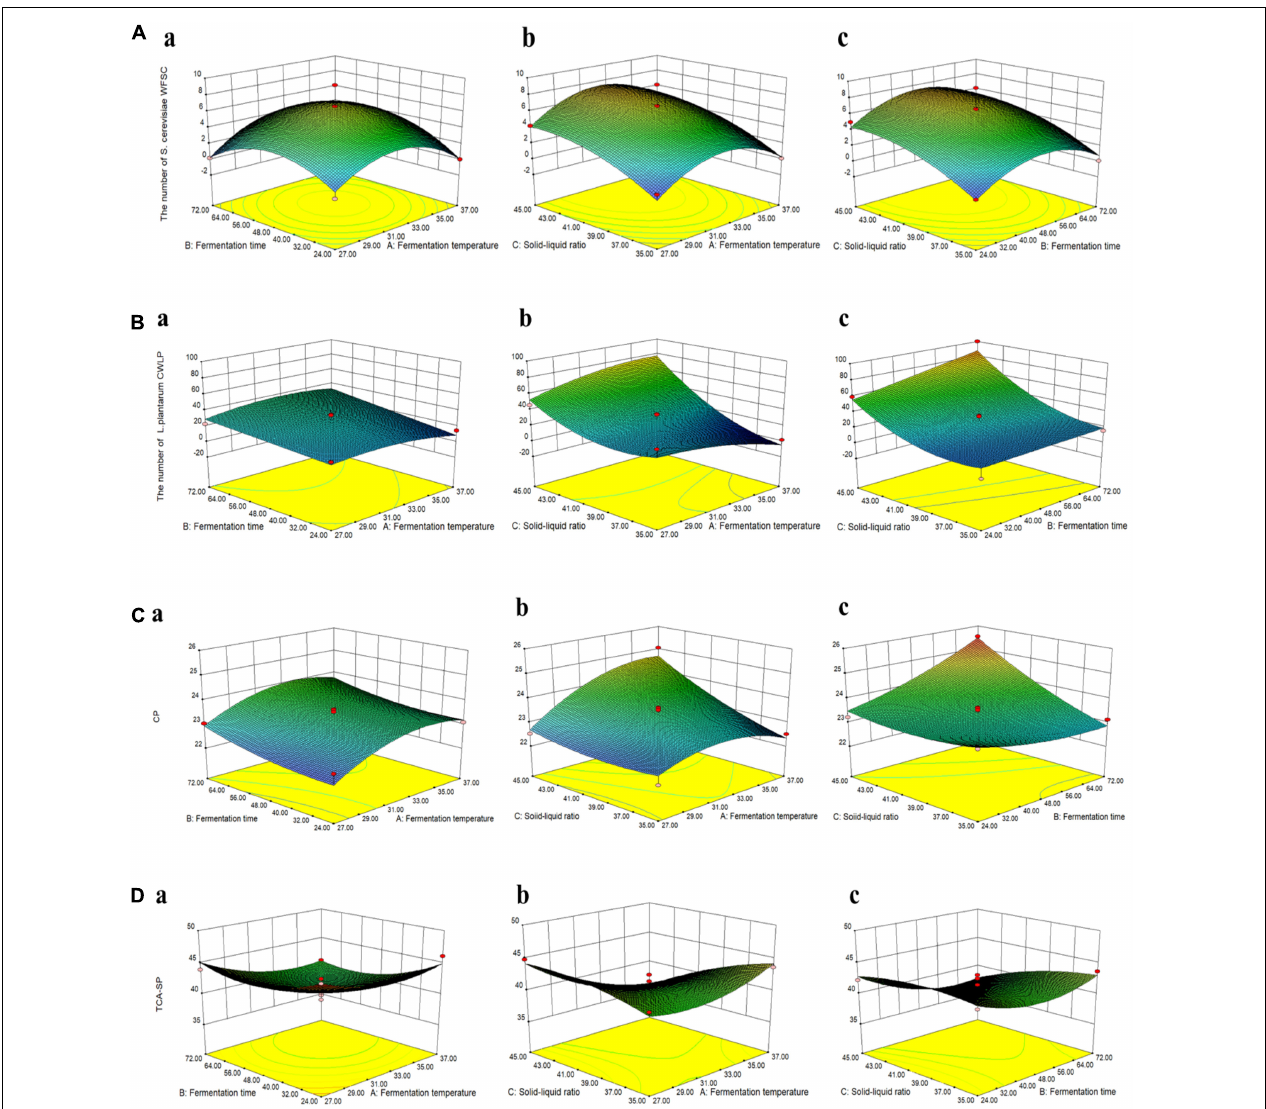
FIGURE 1 | The response surface and contour plots showing the interactive effects of fermentation conditions on the viable count of Pichia kudriavzevii PKWF (A) , the viable count of Lactobacillus plantarum CWLP (B) , crude protein (CP) (C) , and trichloroacetic acid-soluble protein (TCA-SP) (D) of corn byproduct mixture feed fermented with P. kudriavzevii PKWF, L. plantarum CWLP, and neutral protease (CMFPLN) [ (a) fermentation time and fermentation temperature; (b) solid–liquid ratio and fermentation temperature; (c) solid–liquid ratio and fermentation